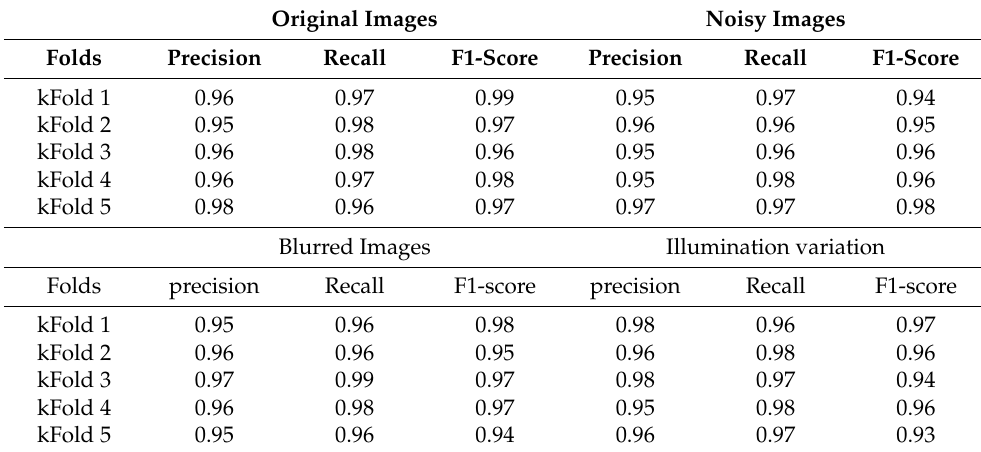
Table 4. Performance analysis of proposed approach for 5 kFold